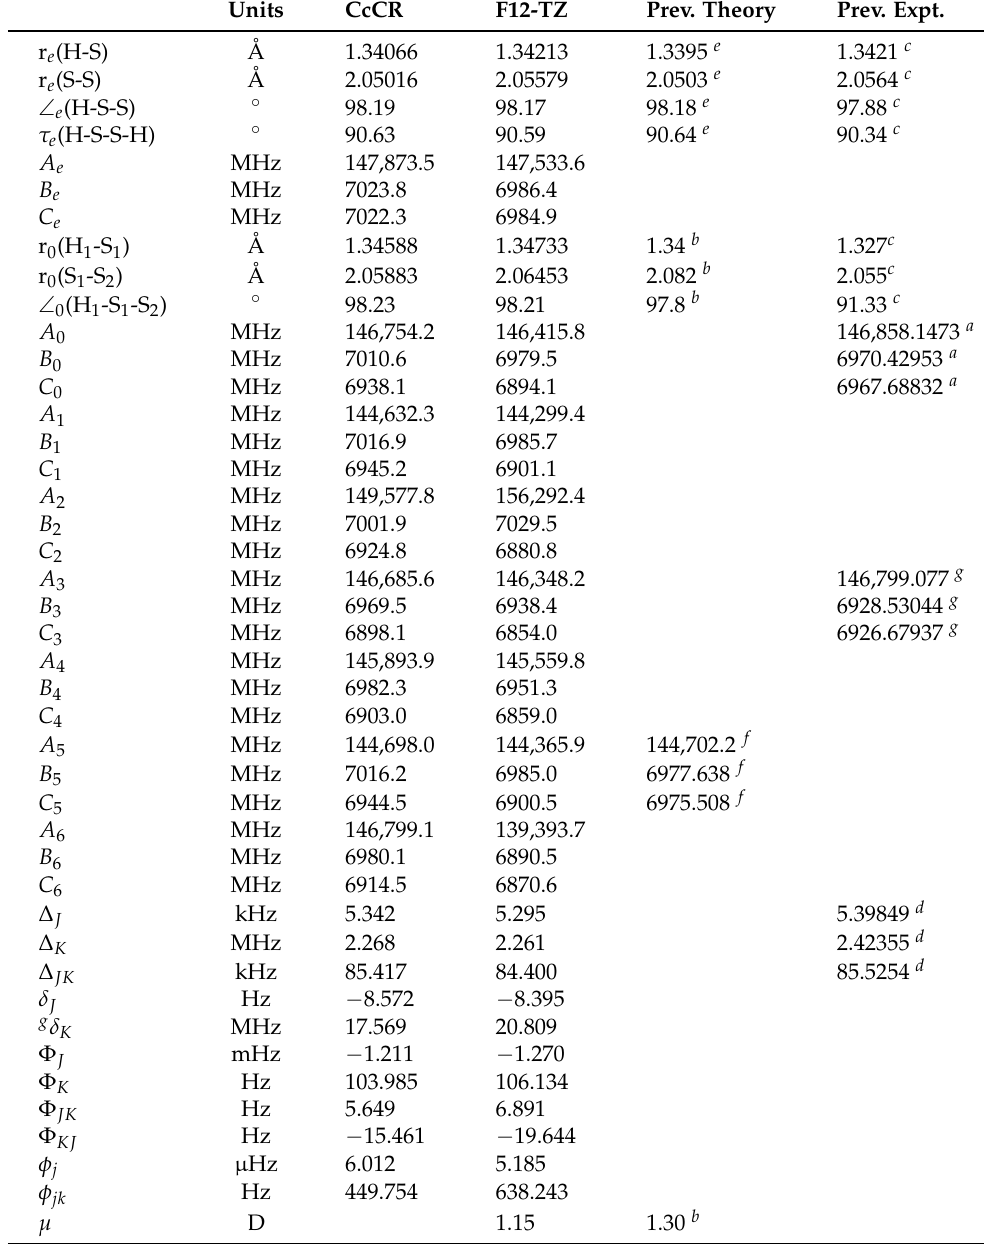
Table 7. Geometrical parameters and spectroscopic constants for HSSH compared to the previous gas-phase experiment.